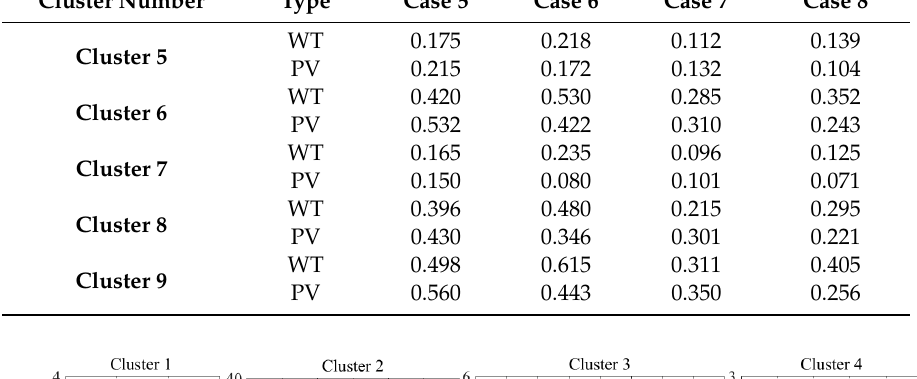
Table 6. Planning capacities of WT/PV of Cases 5–8 for the IEEE 33 bus system.